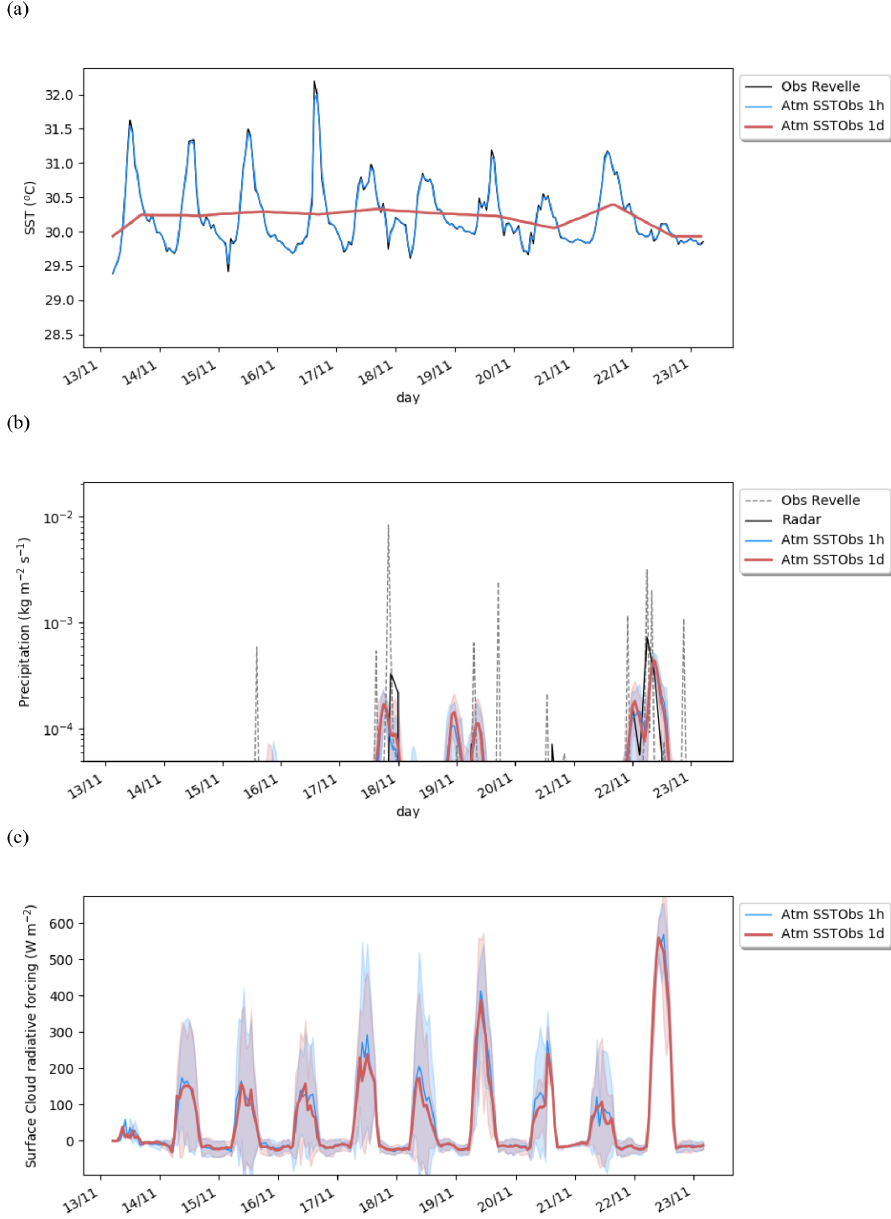
Figure 4. Hourly time series of (a) temperature ( ◦ C), (b) precipitation (kgm − 2 s − 1 ), and (c) surface cloud radiative forcing (Wm − 2 ) in atmospheric forced experiments and observed estimates. The shading represents the spread of the member ensemble given by 2 standard